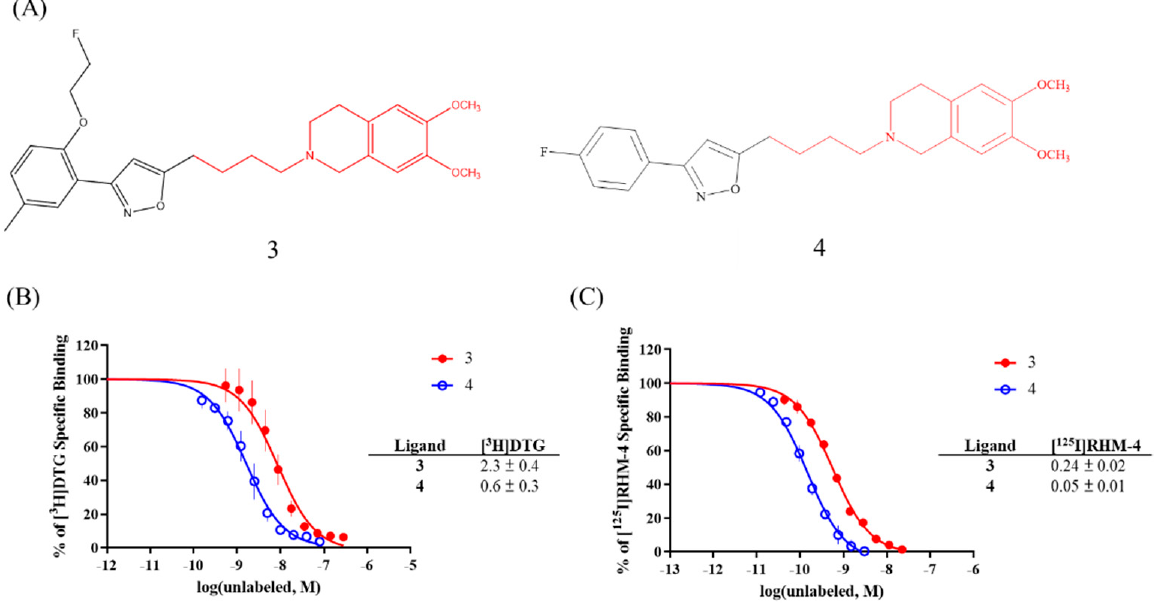
Figure 4. ( A ) The chemical structures of 1 and 2 ; the competition binding results with ( B ) [ 3 H]DTG or ( C ) [ 125 I]RHM-4.